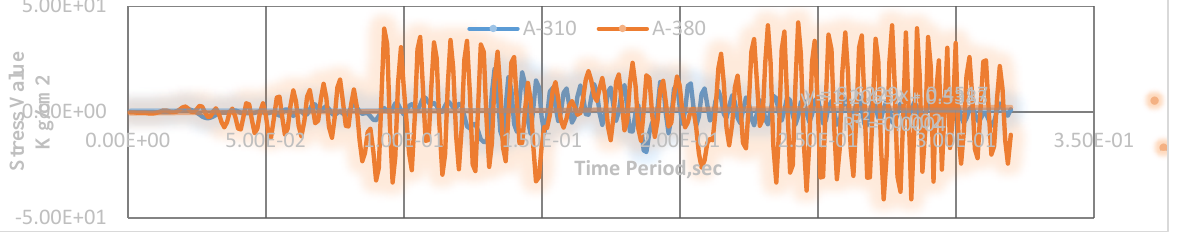
Fig. 8. Stress-Time History Curve for Speed= 160 kmph, h=20cm, E=30000MPa.